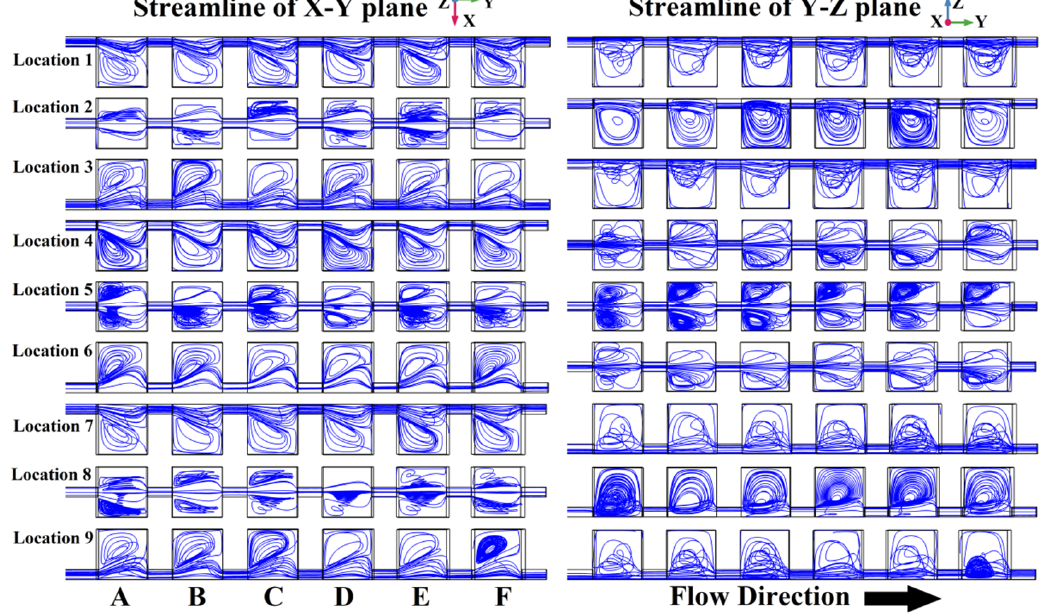
Figure 6. The interior distribution of streamlines in the micromixers with different junction locations.